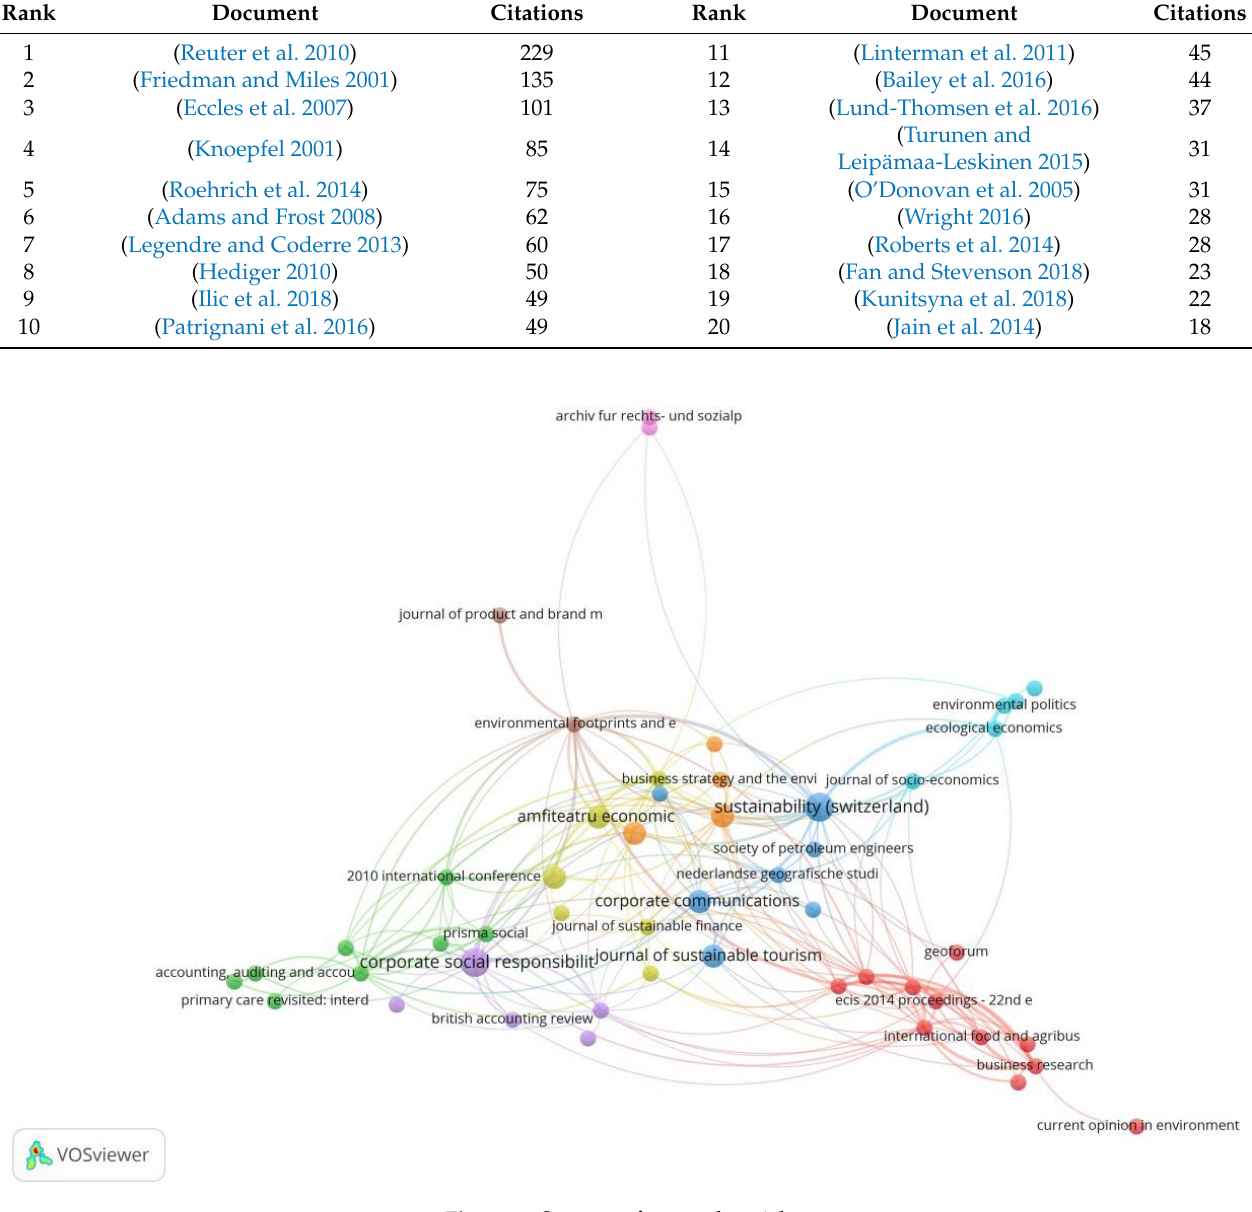
Figure 2. Sources of research articles.